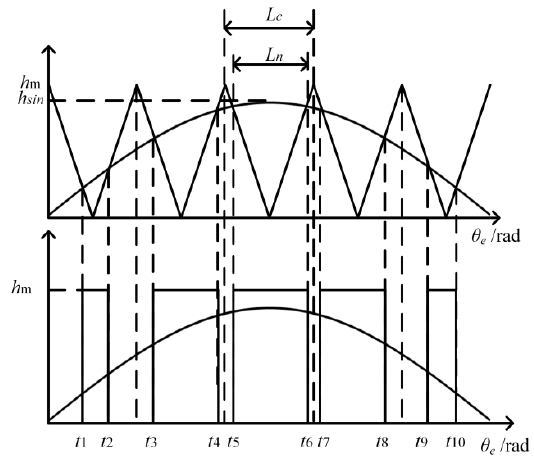
Figure 1. Equal amplitude modulation.